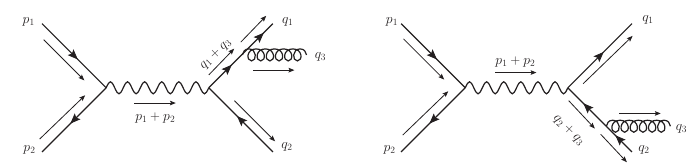
Figure 3: Diagrams for NLO real-radiation